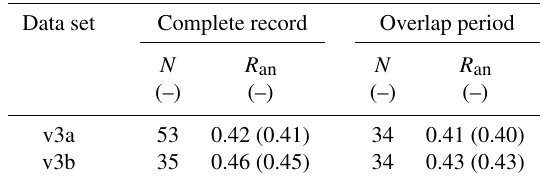
Table 5. Average anomaly correlations for different evaporation data sets (v3a and v3b) against in situ measurements: R an is the anomaly correlation and N is the number of sites included in the sample. The first part of the table reports the averaged statistics over all available sites and the entire study period, while the second part shows the same statistics for a common sample of sites, and an over- lapping study period (2004–2015) for the two data sets. The same statistics for the data sets produced using GLEAM v2 are reported between